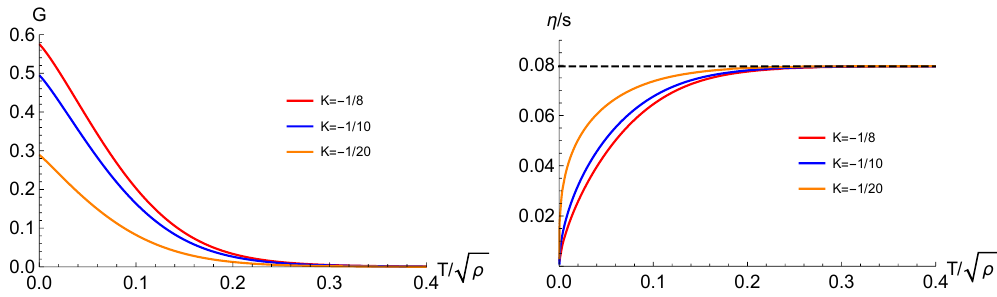
√ ρ for different